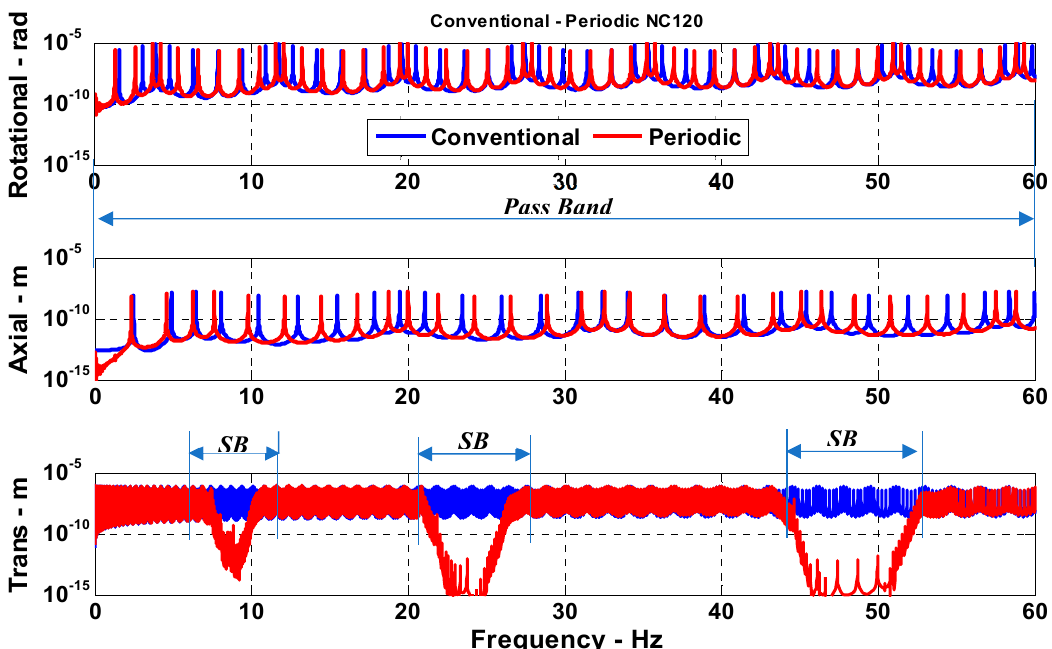
Figure 7. Comparisons between the frequency response characteristics of a conventional drill-string and a drill-string with 60 passive periodic inserts ( SB : Stop band).